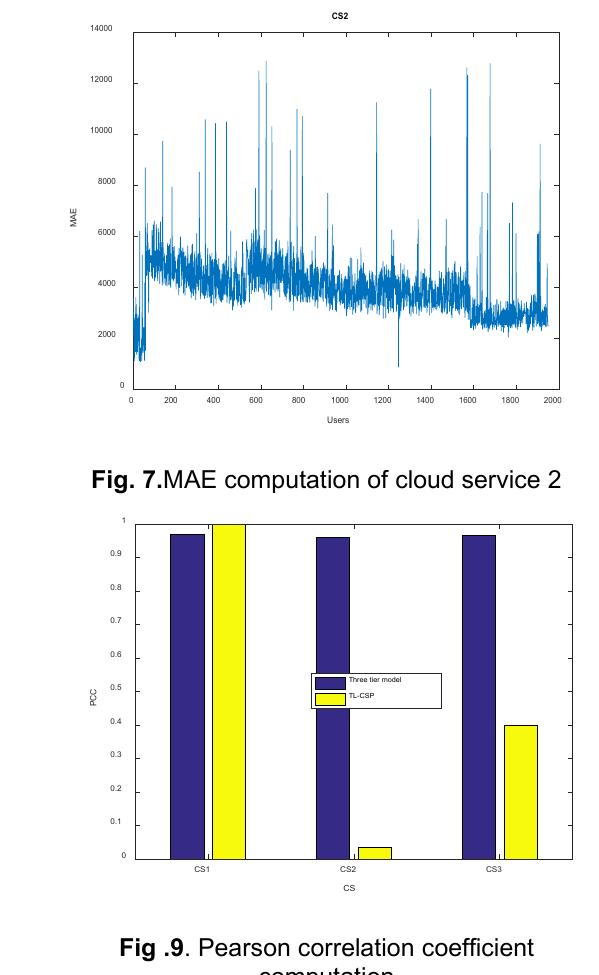
Fig .8. MAE computation of cloud service 3